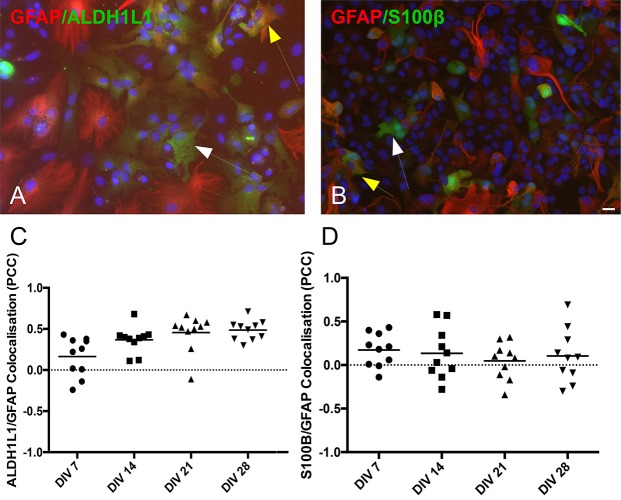
Co-localization of astrocytic markers (GFAP, ALDH1L1, and S100β). (A) Culture example at DIV 21 of astrocytes co-expressing GFAP and ALDH1L1 (yellow arrow) or expressing only ALDH1L1 (white arrow). (B) Culture example at DIV 21 of astrocytes co-expressing GFAP and S100β (yellow arrow) or expressing only S100β (white arrow). Cell nuclei marker H-33342 (blue stain). Scale bar 20 μm. (C,D) Analysis of co-localization across different days in vitro reveals heterogeneity of differentiated astrocytes in protein expression. Pearson’s correlation coefficient of GFAP/ALDH1L1 and GFAP/S100β stains from DIV 7 to DIV 28.